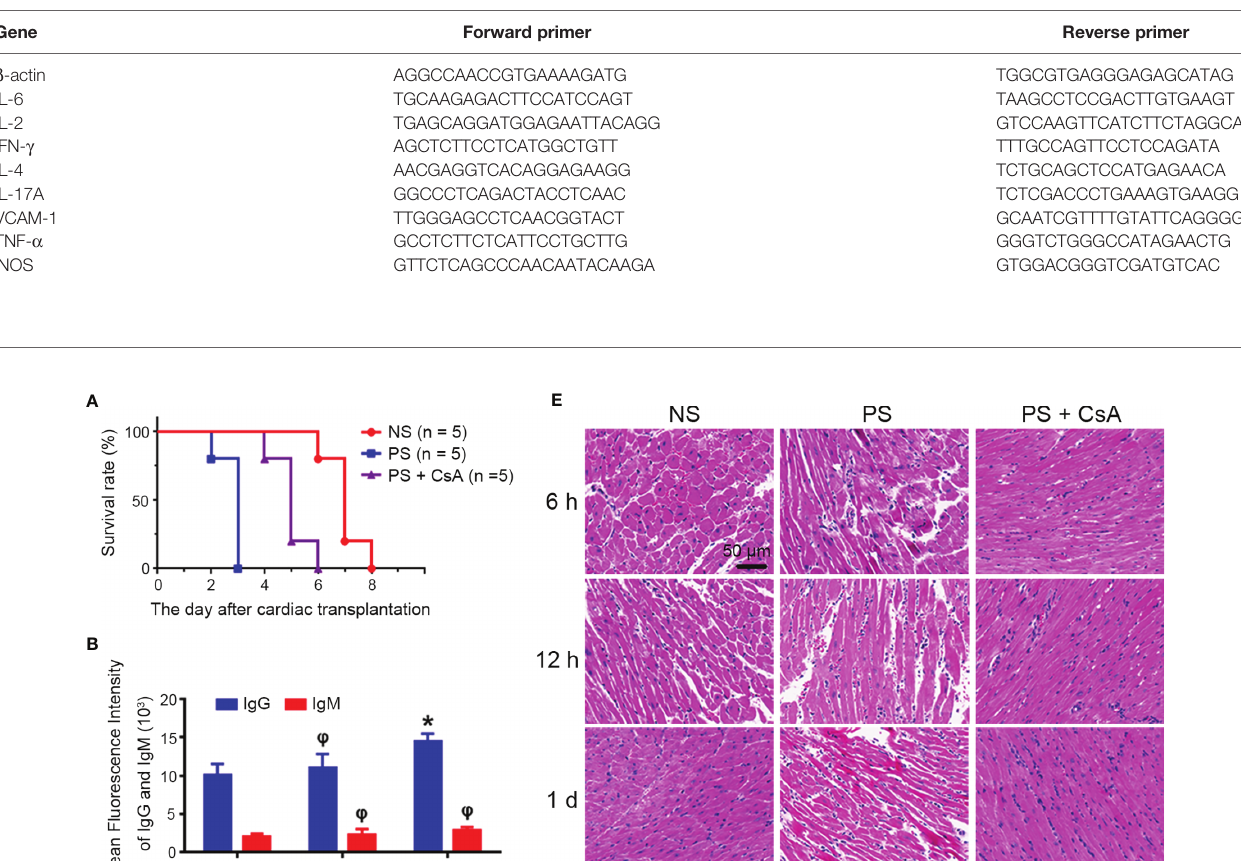
TABLE 1 | List of primers used for qPCR.